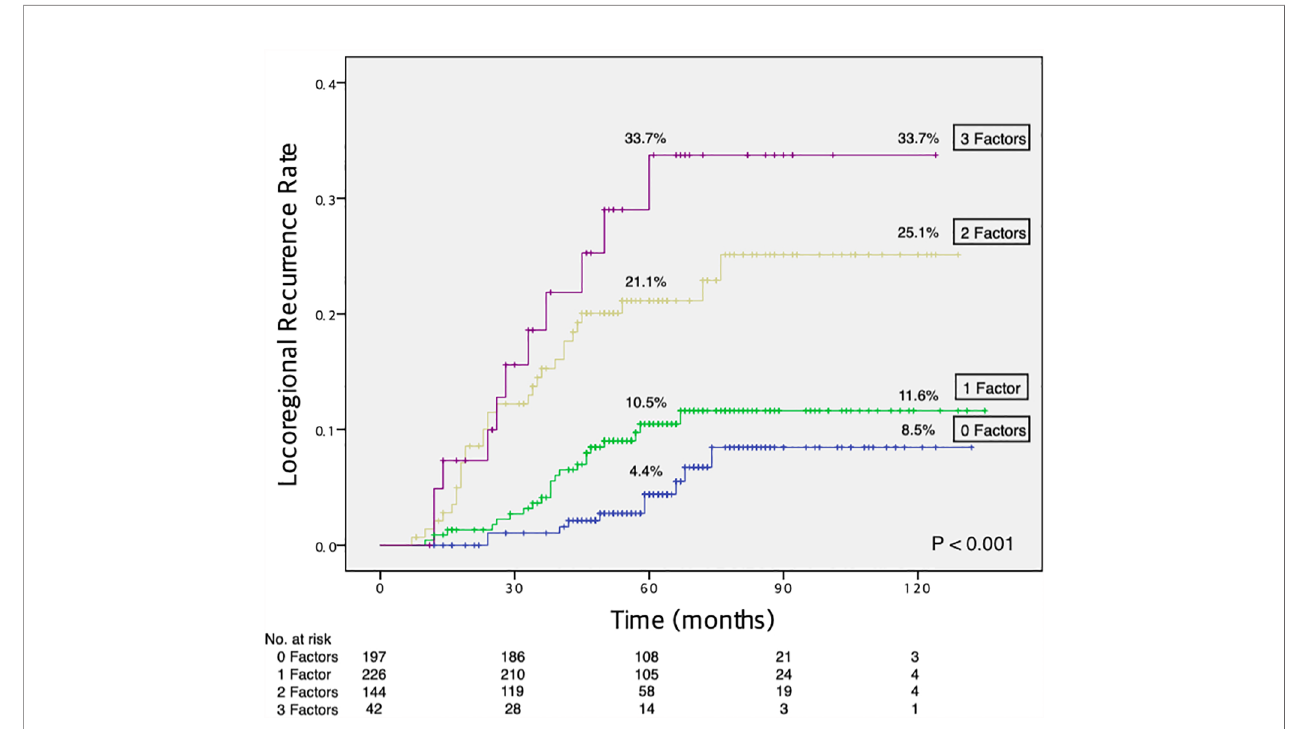
FIGURE 1 | Increased risk of LRR with an increasing number of independent risk factors. LRR, locoregional